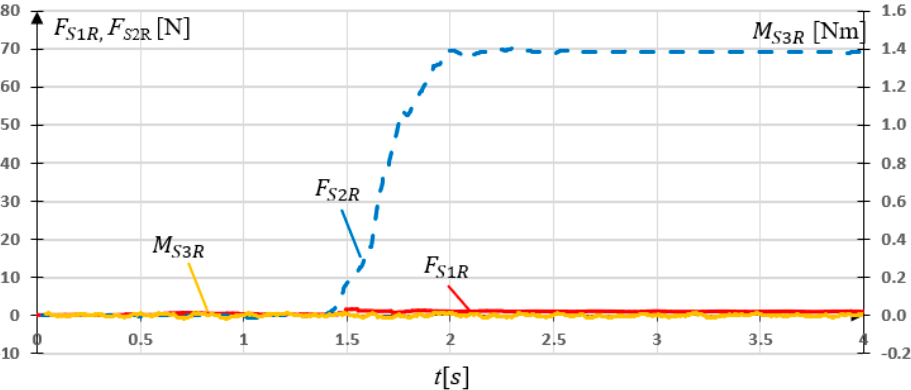
Figure 16. Experimental research results for the grip loaded with 7 kg mass in x direction.